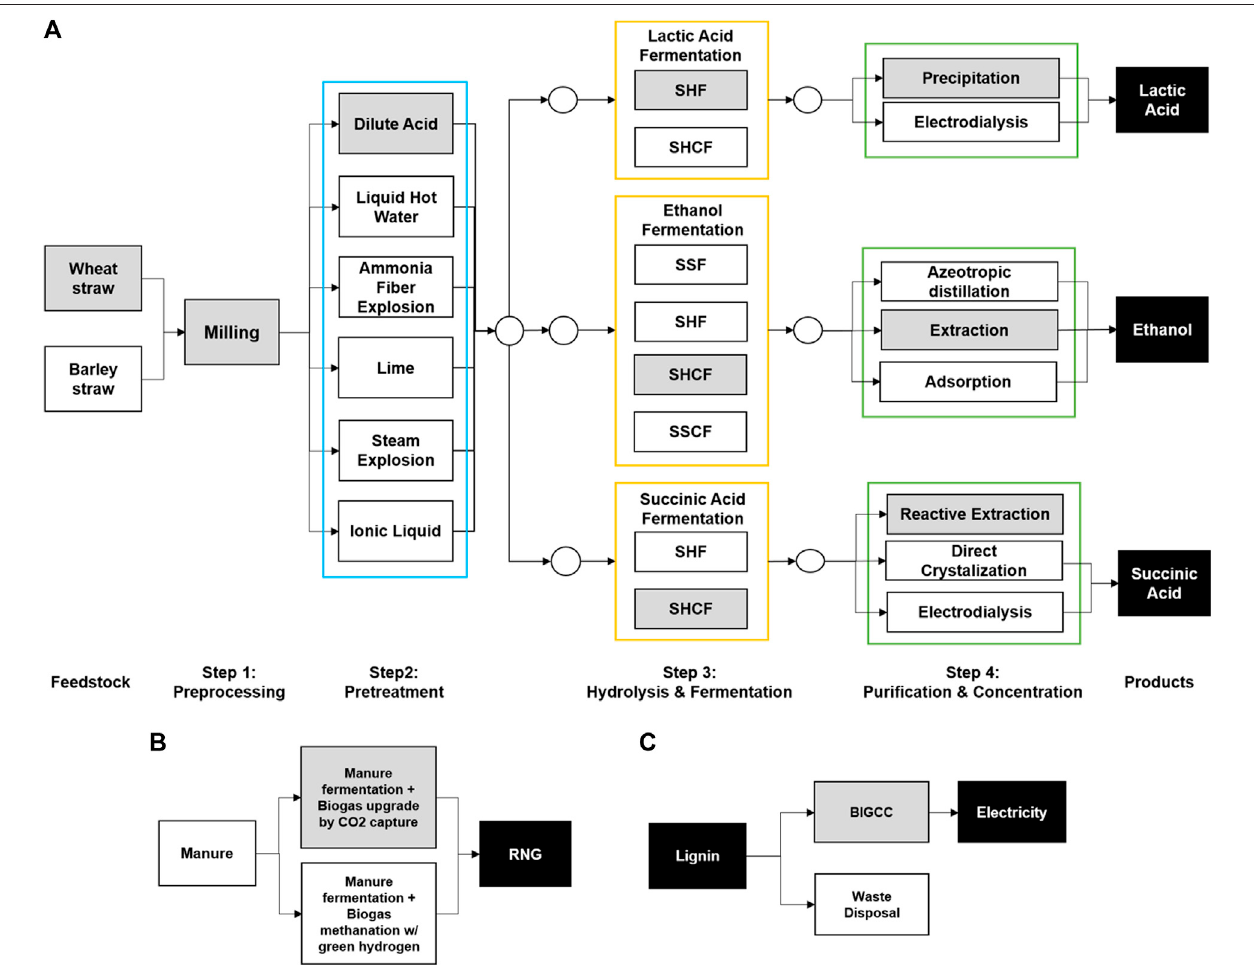
FIGURE7| SolutionA(maximizesOP): (A) LCFconversion, (B) manureconversion,and (C) ligninconversion.Thegreyshadingrepresentsthechoiceoffeedstock and technologies.